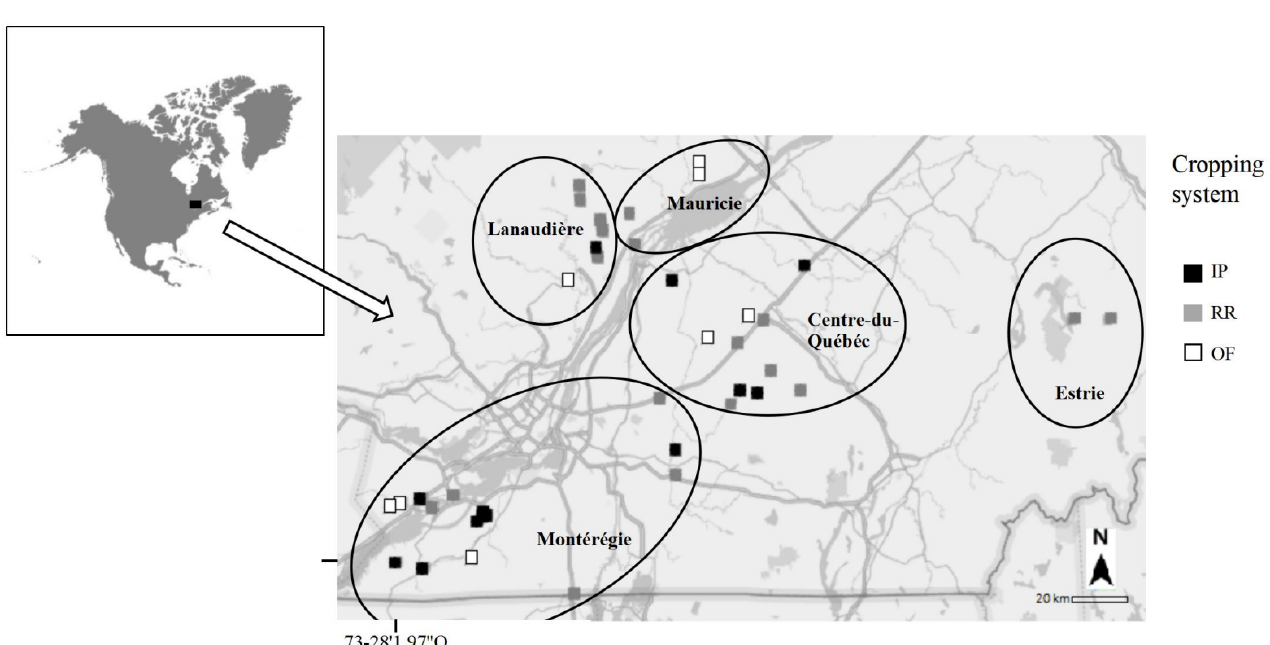
Figure 1. Location of the study sites ( n = 45) on the St. Lawrence Lowlands during the sampling campaign in 2014 before sowing (May 2014) and at harvest (October 2014) for the three cropping